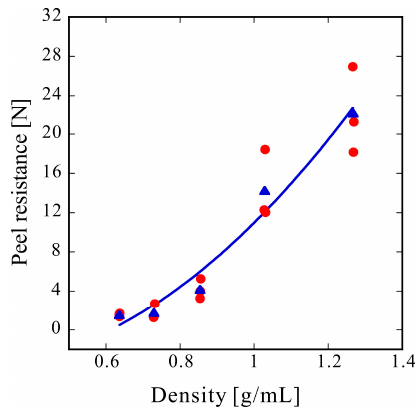
Figure 3. Peel resistance. Experimental results ( red circle ) and averages of three experimental data points ( blue triangle ) at each bulk density and the quadratic fitting result ( blue solid line ).